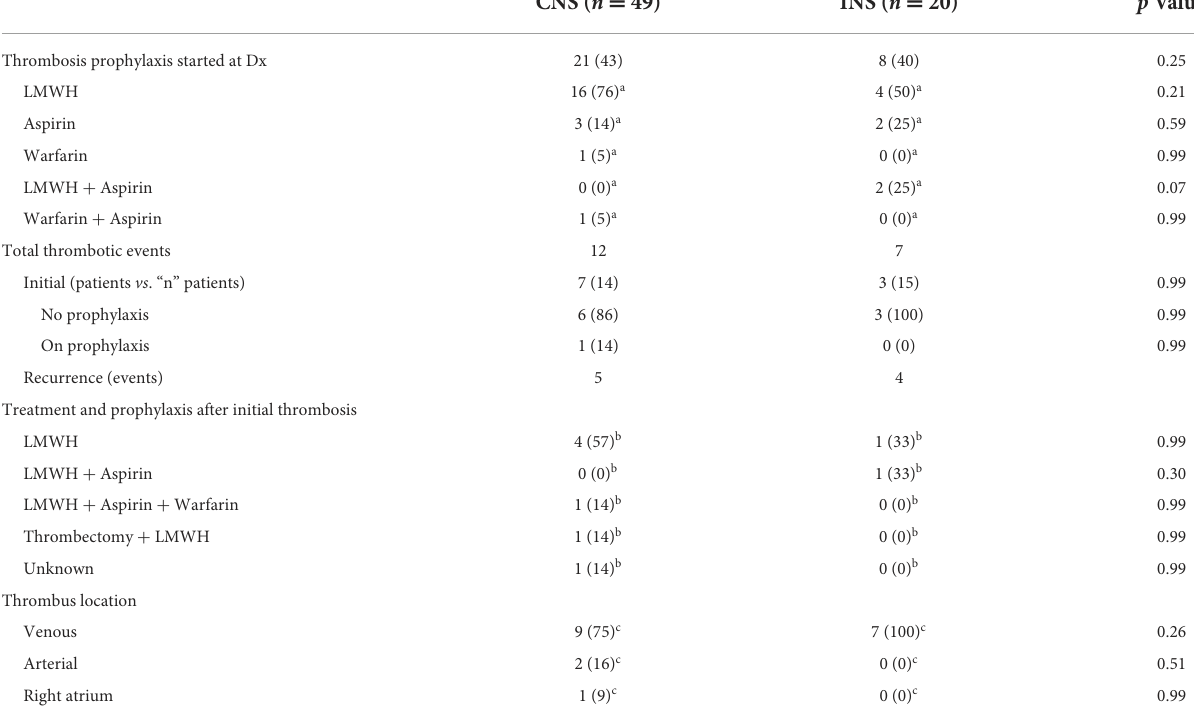
TABLE 3 Thrombosis prophylaxis and incidence in CNS/INS patients.